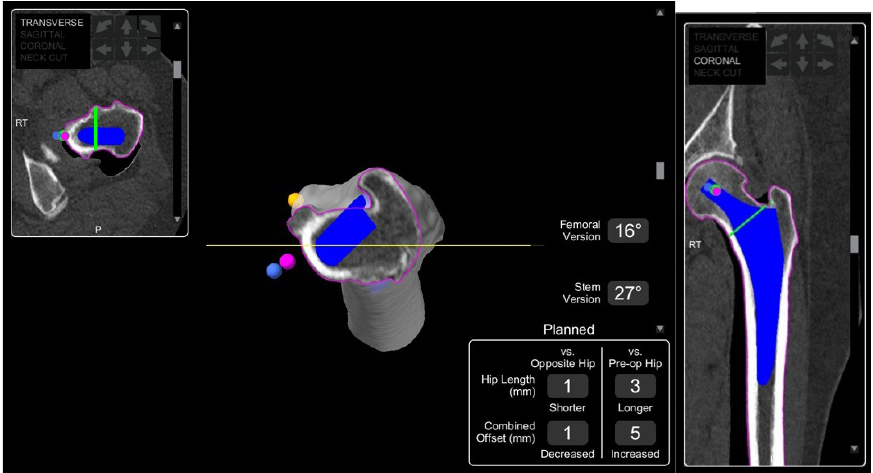
Figure 3. MAKO robotic-arm-assisted system planning of femoral stem insertion in coronal and transverse planes. The dark blue stem position is relative to 0 degrees (yellow horizontal line). The pink dot indicates the native centre of the femoral head, the orange dot represents the centre of the lesser trochanter, and the blue dot landmarks the selected stem head centre. The pink pine indicates the edge of the bone. These colour indications are consistent through all further pre-operative planning images below.